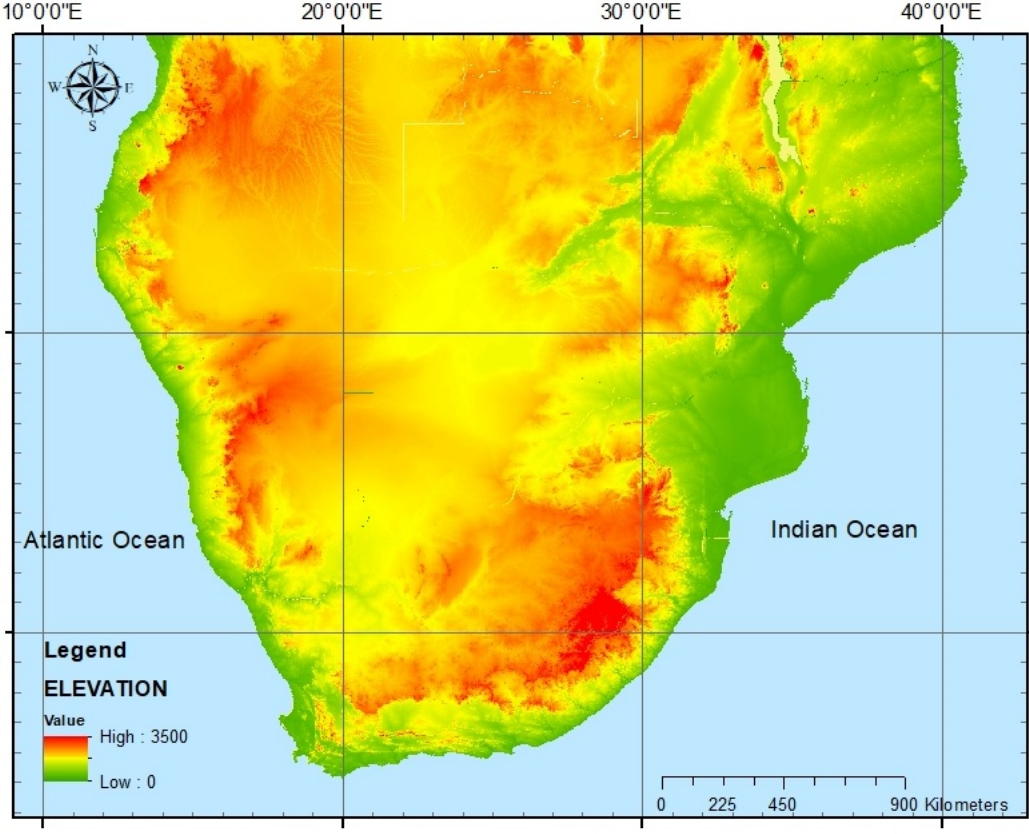
Figure 2. Southern Africa elevation map.